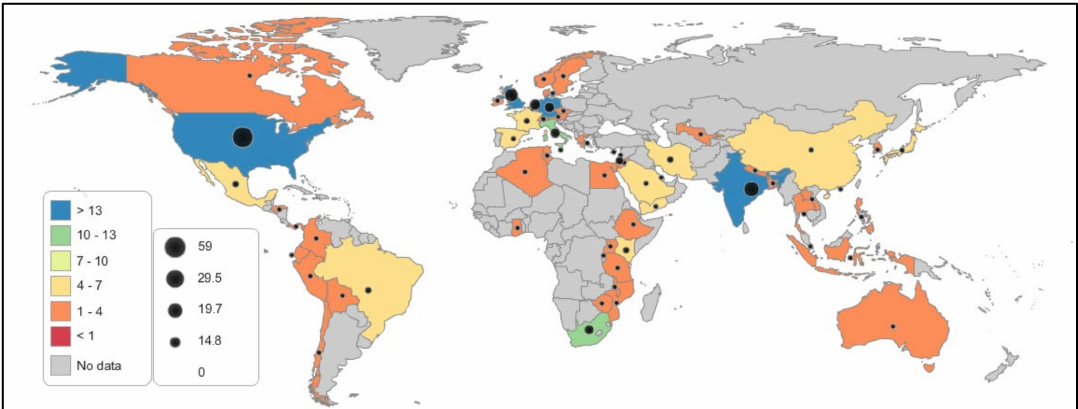
Figure 5. Nation–level production regarding intermittent water supply; a worldwide perspective of the research productivity at the country level. The intensity of colors elucidates the number of published works. The size of black circles represents the output of each country (i.e., the larger the circle, the higher the performance of the country with respect to the number of publications). The global map was created using Statplanet Interactive Mapping and Visualization Software, www. statsilk.com, free license. Table 1. Countries’ key bibliometric performance indices associated with research on intermittent water supply systems (IWSSs); top 10 most-productive countries.